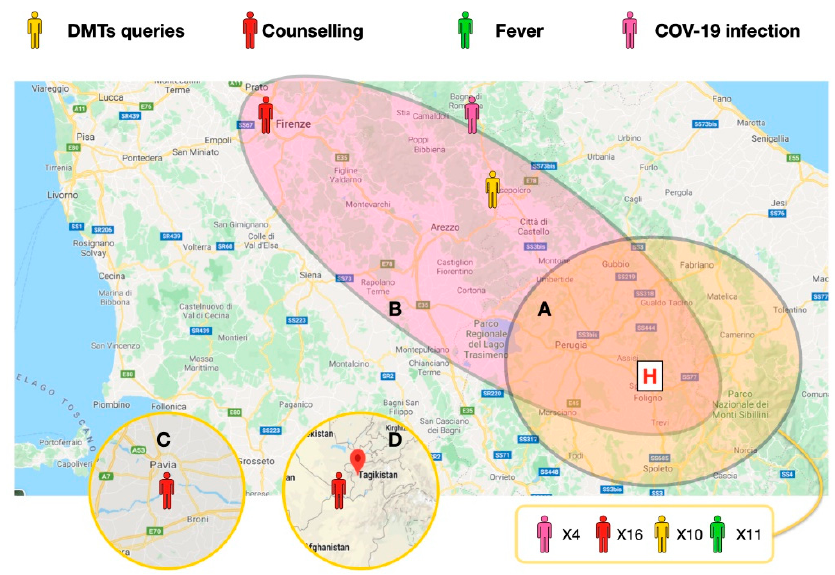
Figure 2. Central Italy map: Umbria, Marche, Toscana, Emilia Romagna. Patient localization and driving distances from the MS clinic. ( A ) Within a 60 min drive. ( B ) within a 120 min drive. ( C ) and ( D ) Cases in Lombardy and central Asia. The main reasons for the televisits in the 46 cases. The defined COVID-19 cases localization is depicted in pink; fever of unknown causes is depicted in green; Disease Modifying Drugs (DMTs) related queries and counseling for social distancing are depicted in yellow and red, respectively. All the calls in the closer areas are reported in a single box (41 cases).